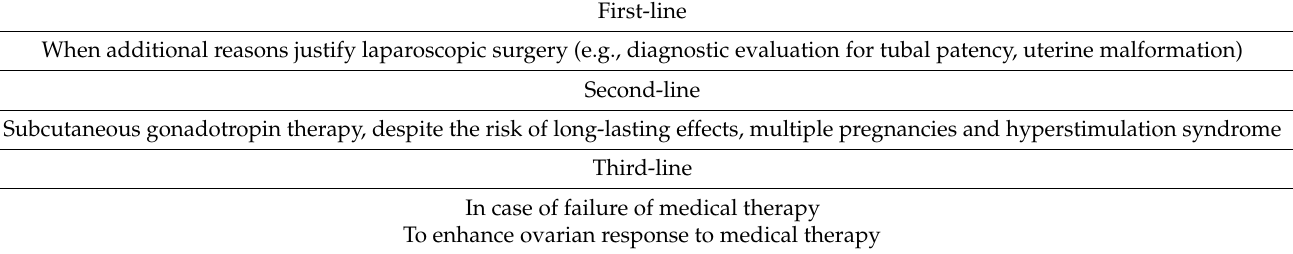
Table 2. Ovarian drilling indications in anovulatory infertile women with polycystic ovary syn- drome